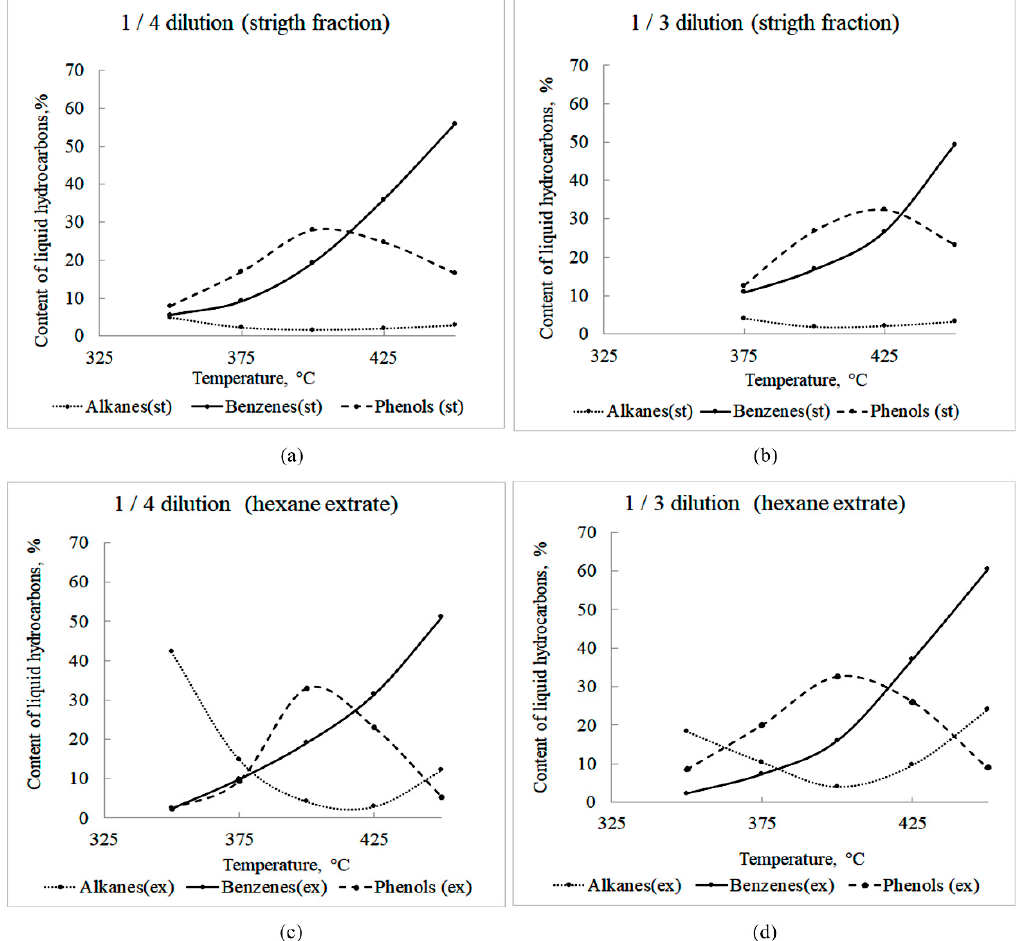
Figure 7. Effect of temperature on the content of alkanes, benzenes and phenols in liquid products of thermal dissolution of biochar in: ( a ) strait fraction fractions of liquid products in dilution with tetralin 1/4, ( b ) strait fraction fractions of liquid products in dilution with tetralin 1/3, ( c ) hexane extracts fractions of liquid products in dilution with tetralin 1/4, and ( d ) hexane extracts fractions of liquid products in dilution with tetralin 1/3.